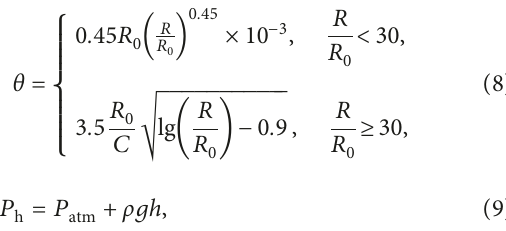
Figure 2: (a) Lagrangian elements: x , u , F , and m in the node and σ , ε , P , e , and ρ in the element center; (b) Eulerian elements: x in the node and other variables in the element center; (c) fluid-structure interaction interface: Euler as the pressure condition for Lagrange and Lagrange as the velocity condition for Euler. Blue represents the material in the Eulerian element [25, 32, 37]. σ , ε , P , e , ρ , x , u , F , and m are the stress, strain, pressure, energy, density, coordinate, velocity, force, and mass,